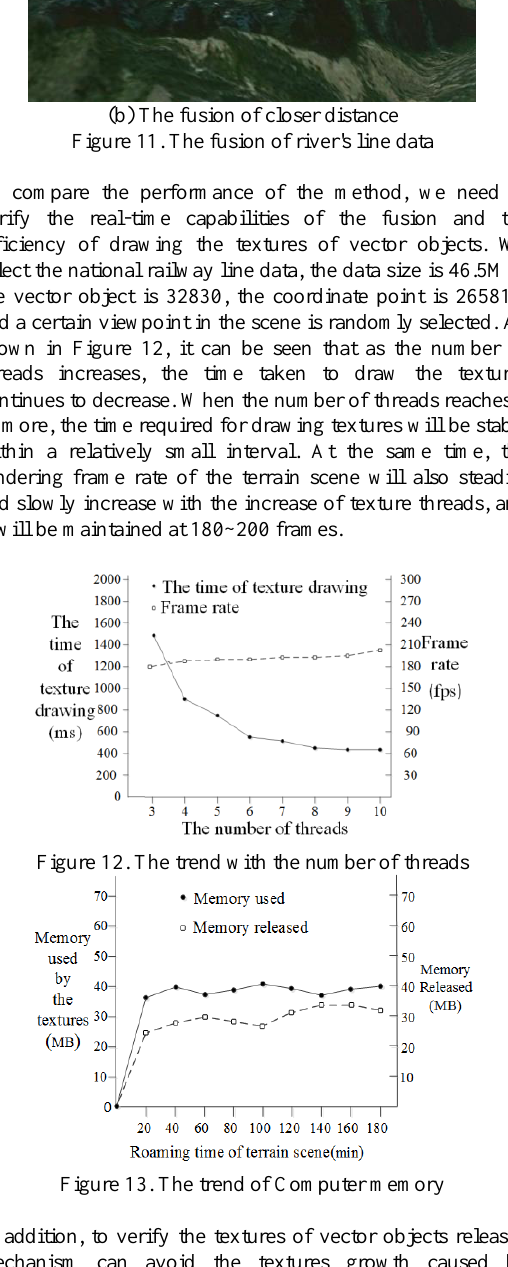
(b) The fusion of closer distance Figure 11. The fusion of river's line data